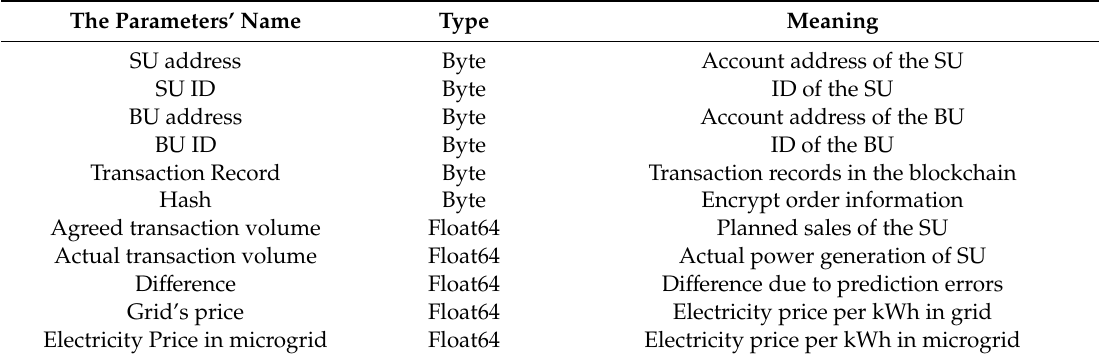
Table 7. Basic elements of error compensation chain